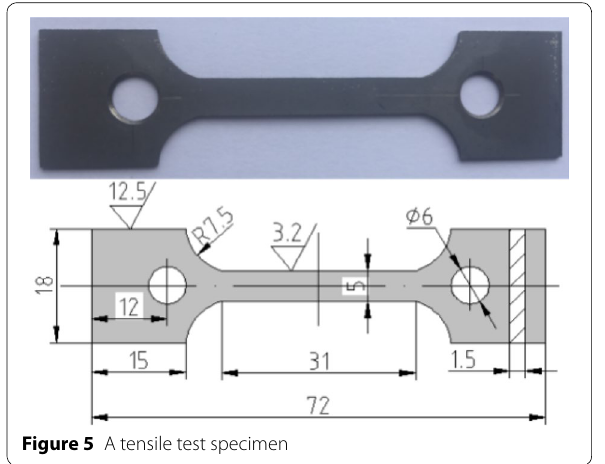
Figure 5 A tensile test specimen